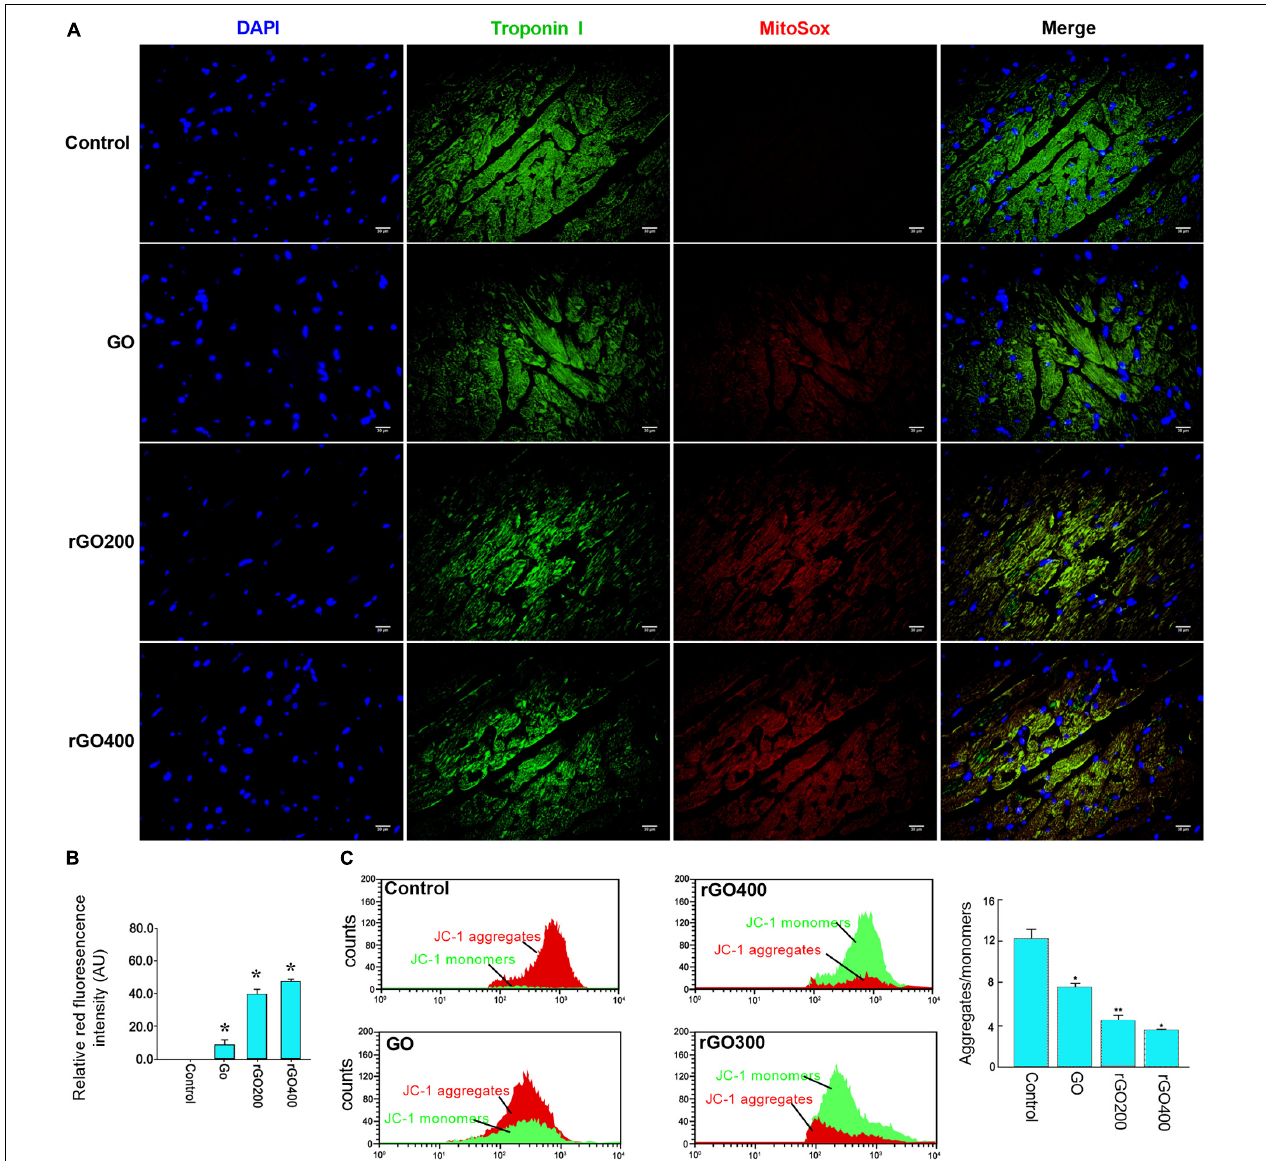
FIGURE 5 | In vivo mitochondrial ROS generation and membrane potential in mice heart section. (A) The representative MitoSox staining of the heart sections from the control and GO- and rGO-treated mice. Troponin I was used as a cardiac marker. (B) The relative MitoSox staining intensity of mouse heart section ( n = 2). (C) Representative flow cytometry analysis of the ratio of JC-1 monomers and JC-1 aggregates in mouse heart tissues (left) and the quantified bar graph (right) ( n = 3). * p < 0.05; ** p <